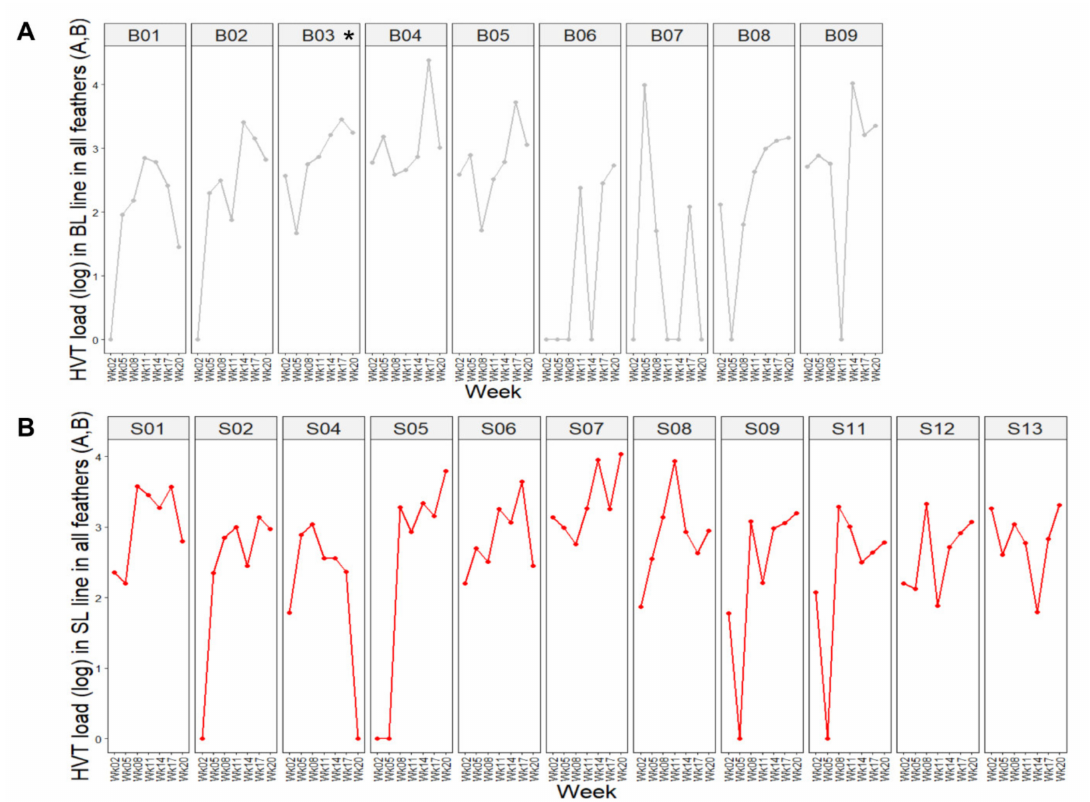
Figure 3. Dynamic of HVT load per subject over time. The HVT load unit is HVT genome copy number per million cells. Each dot corresponds to the HVT load at a time point. ( A ) BL chickens. ( B )